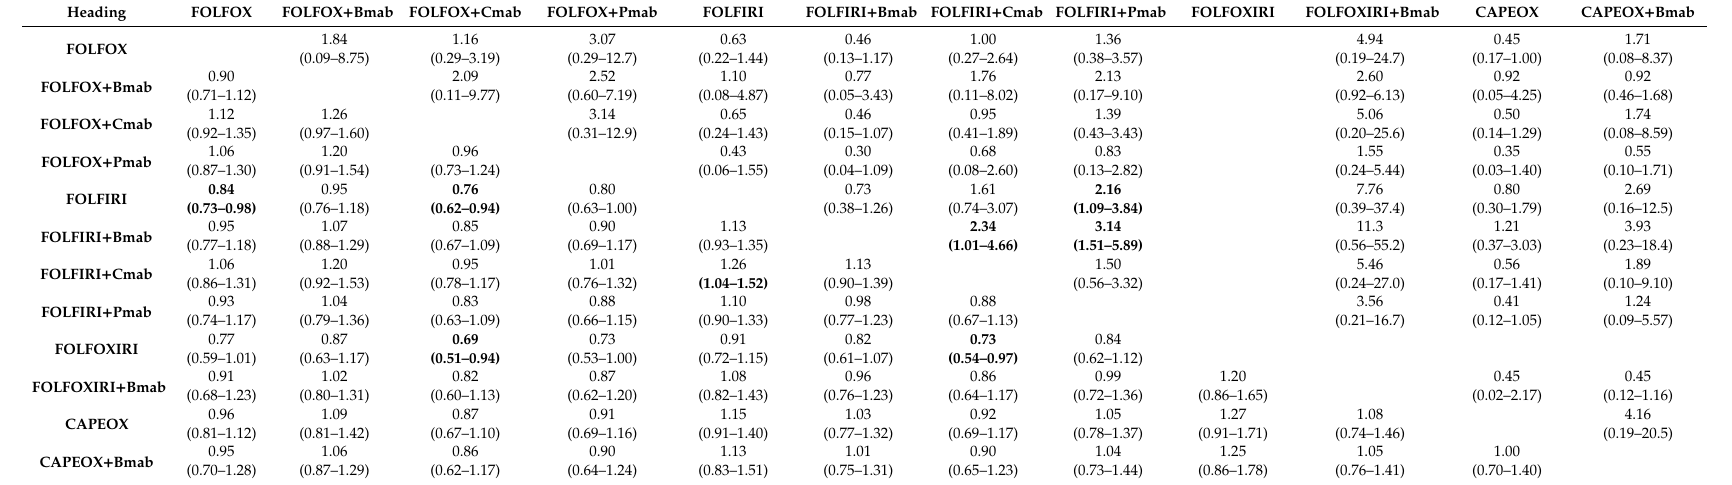
Table 3. Comparative e ffi cacy and safety of advanced or metastatic colorectal cancer